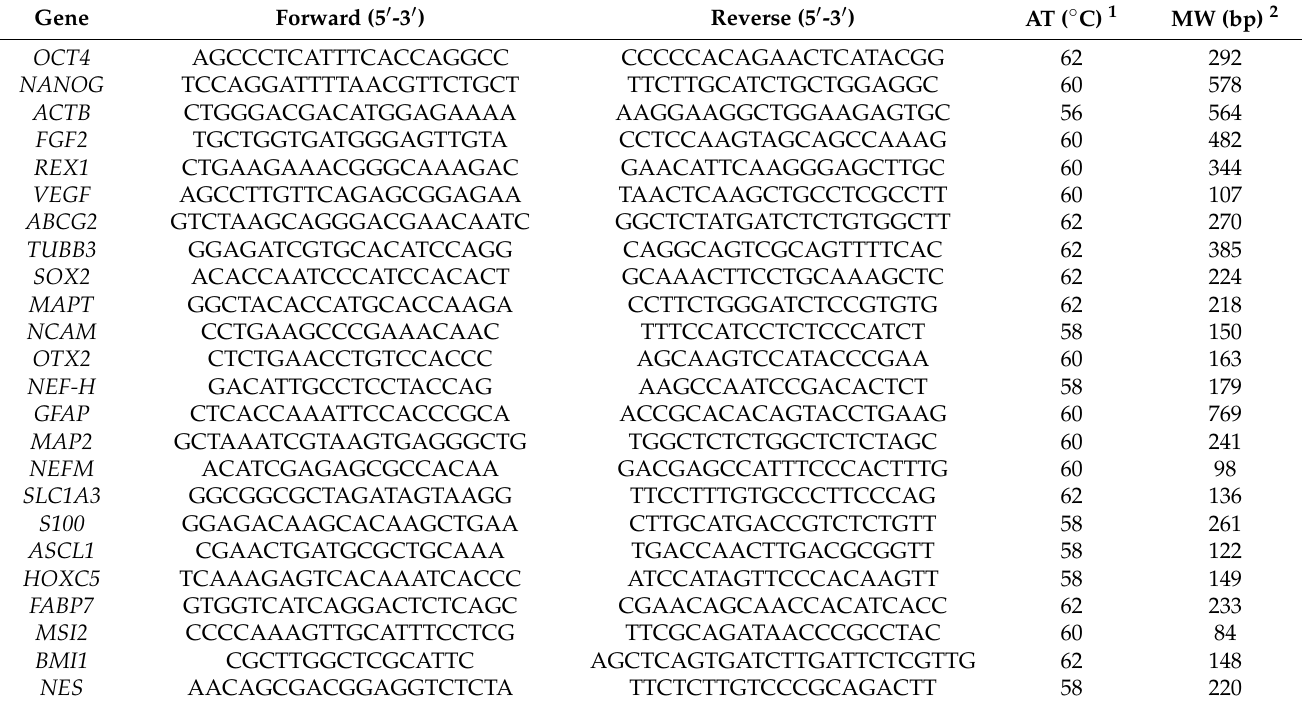
Table 3. Primers for